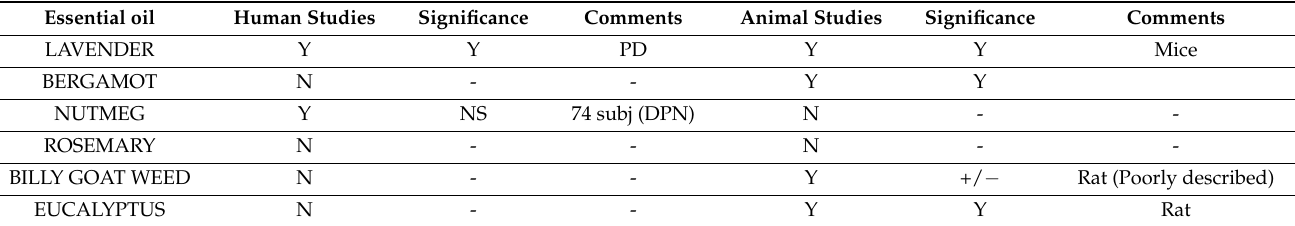
Table 1. Essential Oil Controlled Neuropathic Pain